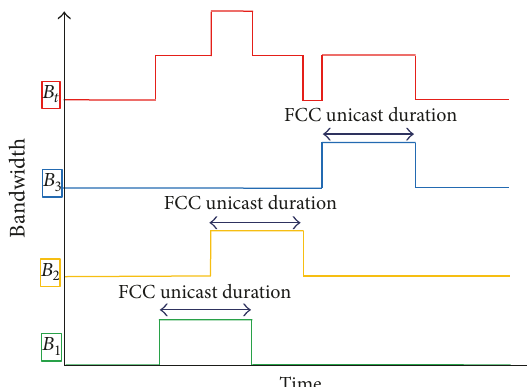
Figure 5: FCC unicast bandwidth.